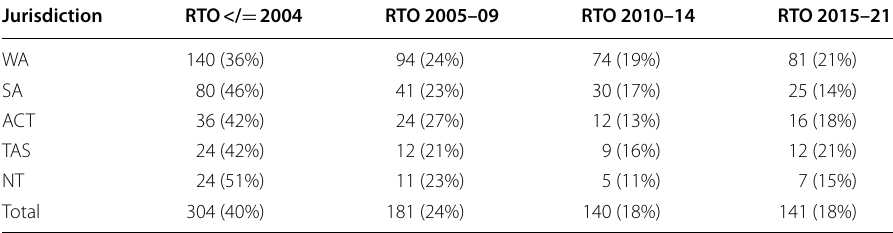
Table 2 Initial registration year as a Registered Training Organisation